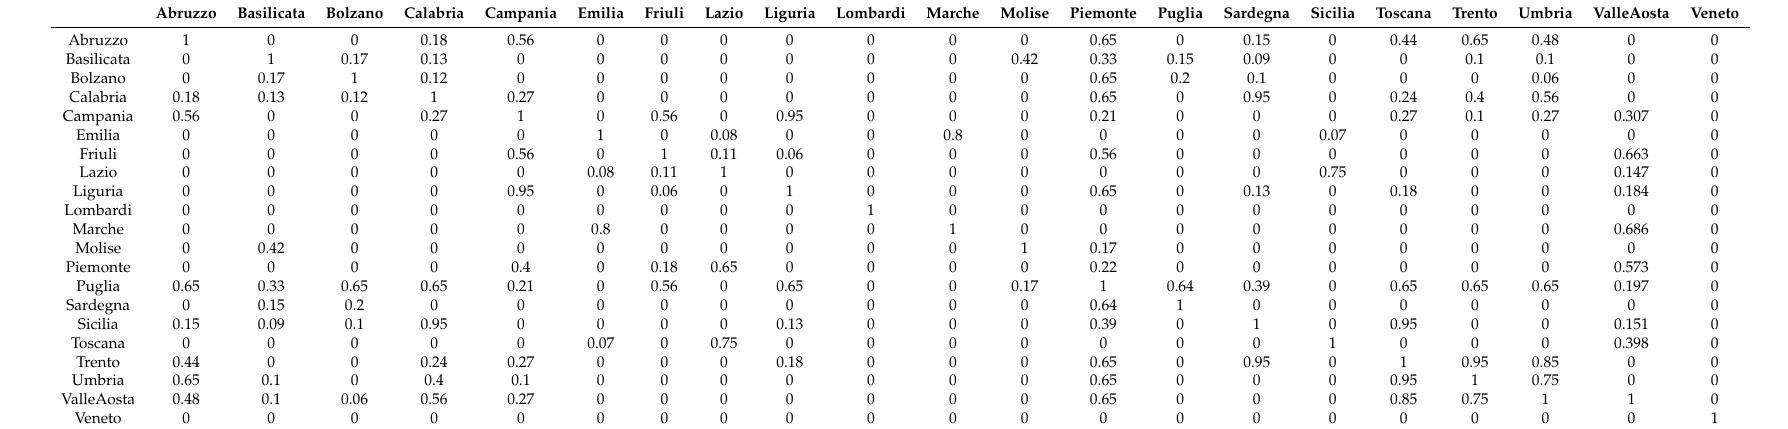
Table A55. Similarity values of Swabs network in the study period.